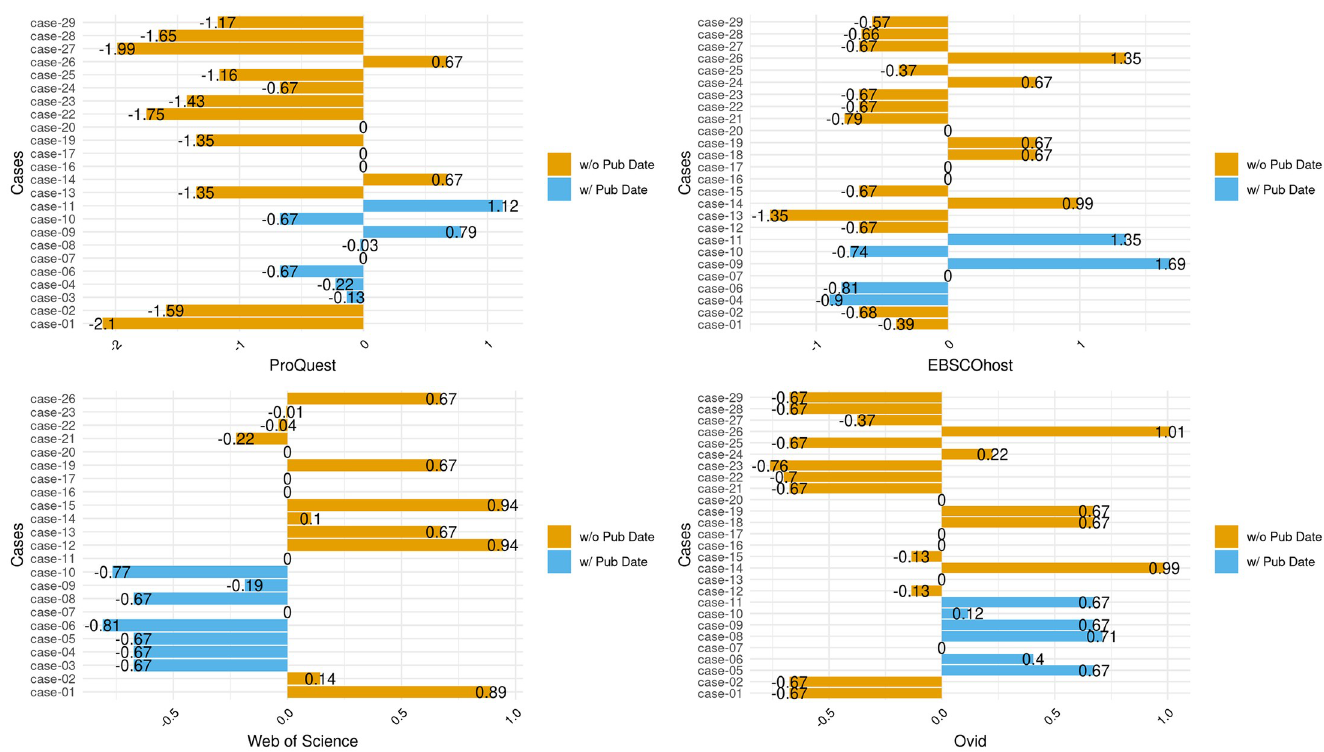
Fig 7. Deviations per case and platform. Deviations per case and platform with deviations centered around PubMed MEDLINE. Cases exclude outliers.